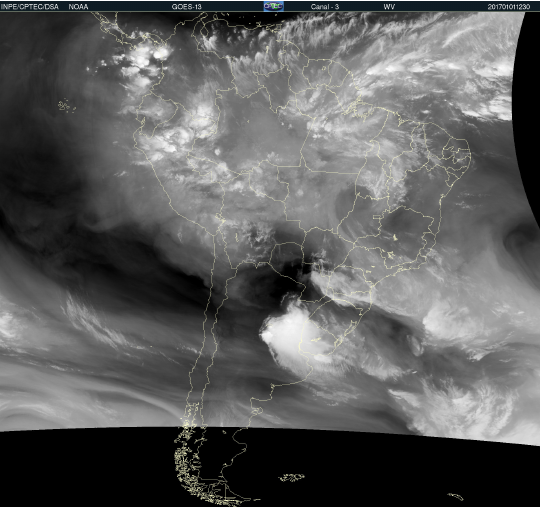
Figure 3. GOES 13 satellite image in the WV channel on 1 January 2017 at 12:30